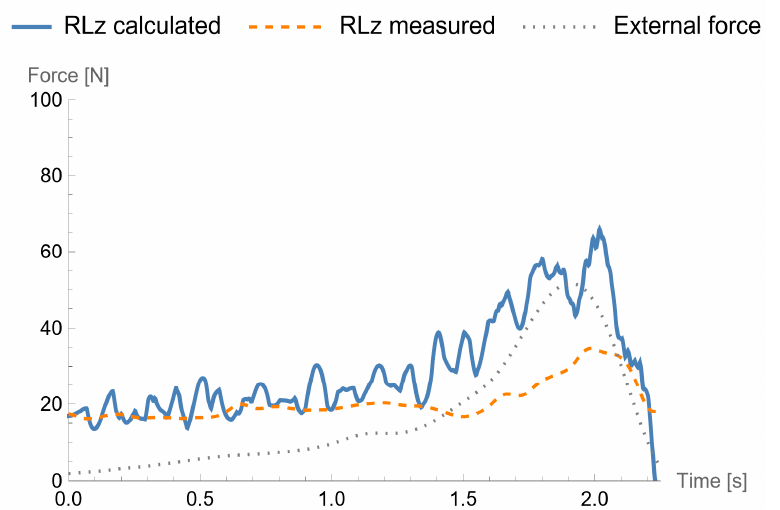
Figure 13. The vertical component, RL y , of the GRF for the left foot in the case of the external force-caused fall with a single pull. The RL y measured with the dynamometric plate is drawn using the dashed line, and the RL y calculated is drawn using the solid line. The dotted line presents the time course of the external force magnitude.